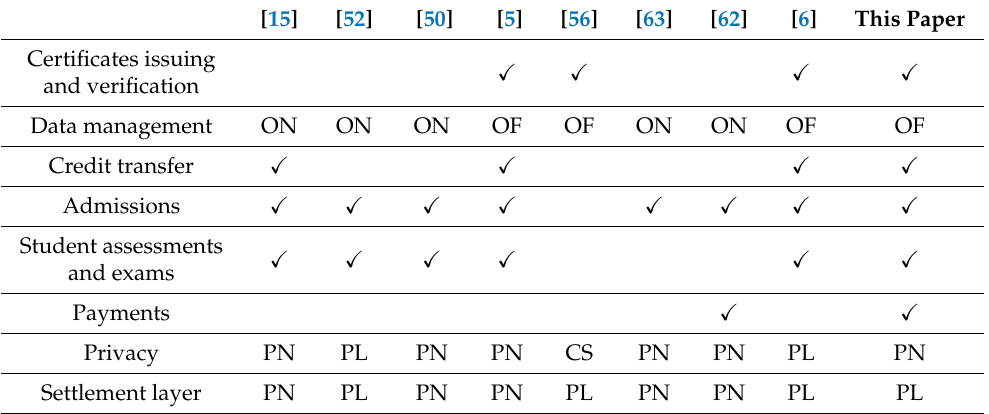
Table 7. Comparison with the mentioned systems.